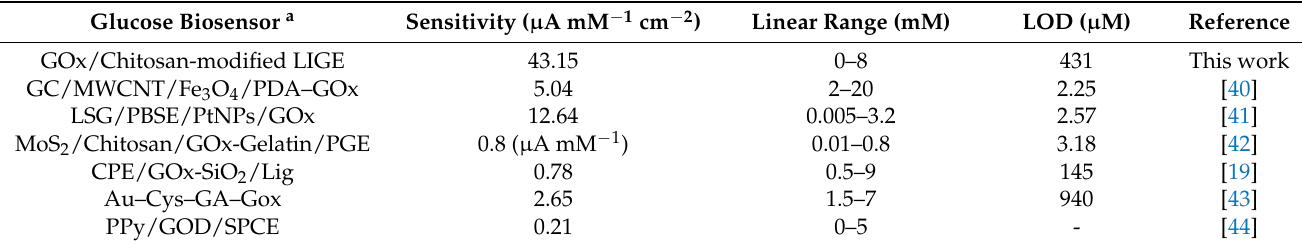
Figure 5. ( a ) Chronoamperometry response with different concentrations of glucose; ( b ) the relationship between the glucose concentration and the chronoamperometric current response at 60 s. Table 1. Comparison of the analytical performance of glucose biosensors.